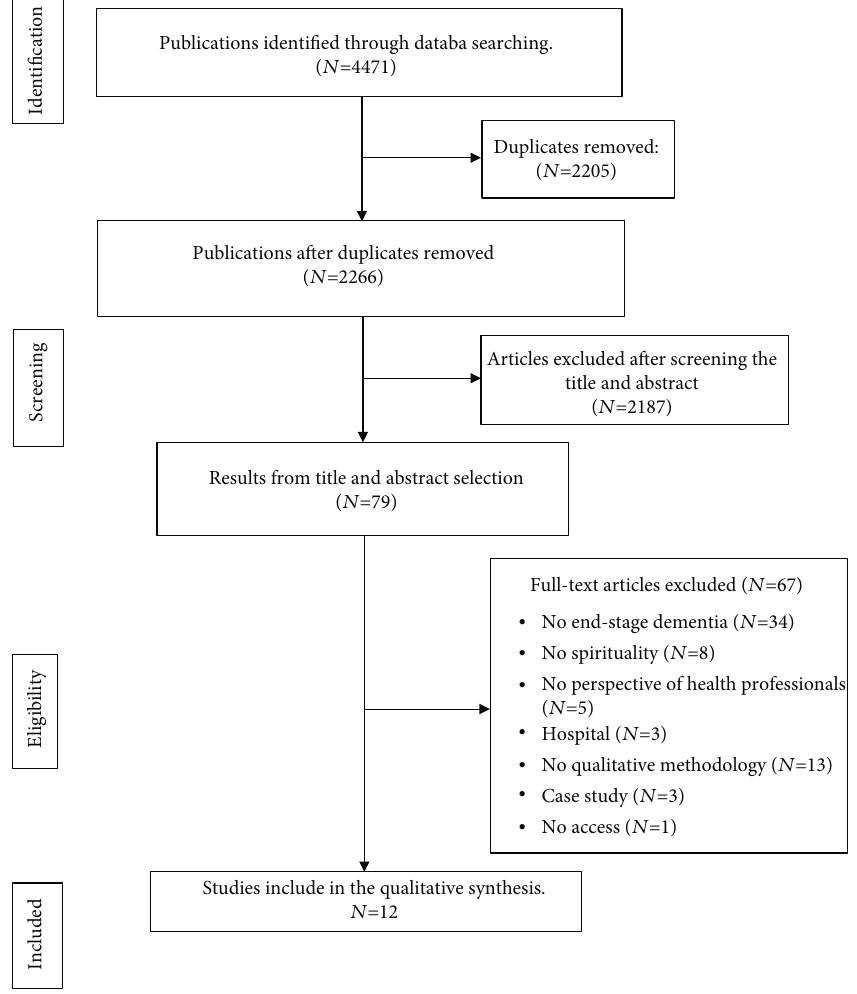
Figure 1: Search